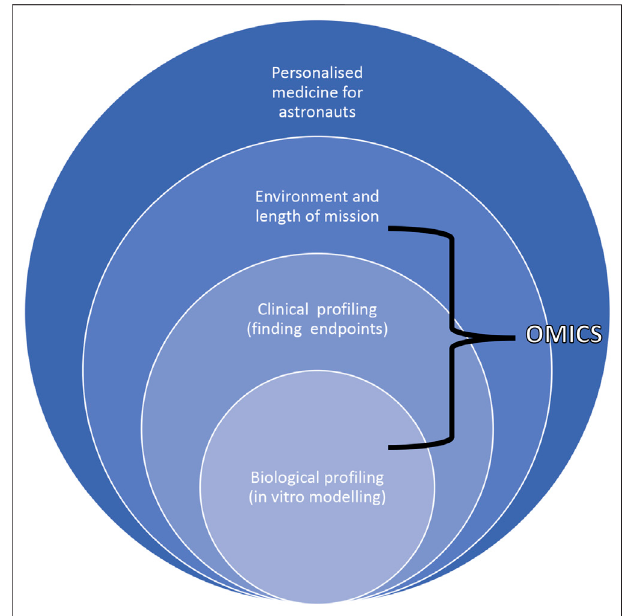
FIGURE6| Schemedescribingthedependenceofbiologicalandclinical pro fi ling with environmental cues and length of mission to accomplish personalized approaches for astronauts highlighting how omics tools can be used to move from correlations to